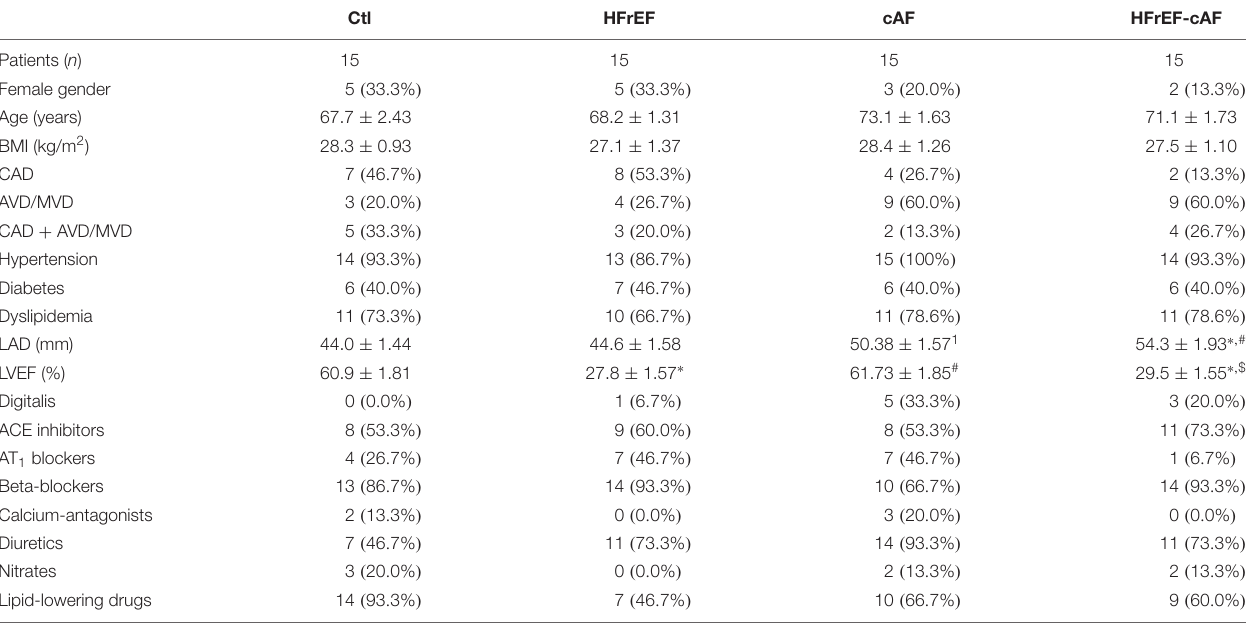
TABLE 1 | Clinical characteristics of patient samples employed for multicellular action potential